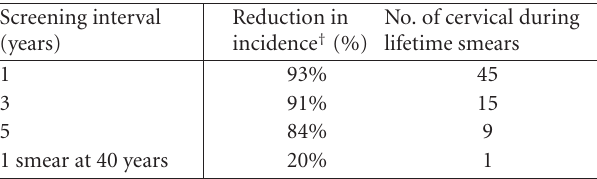
Table 7: Impact of screening interval on incidence of disease. Screening